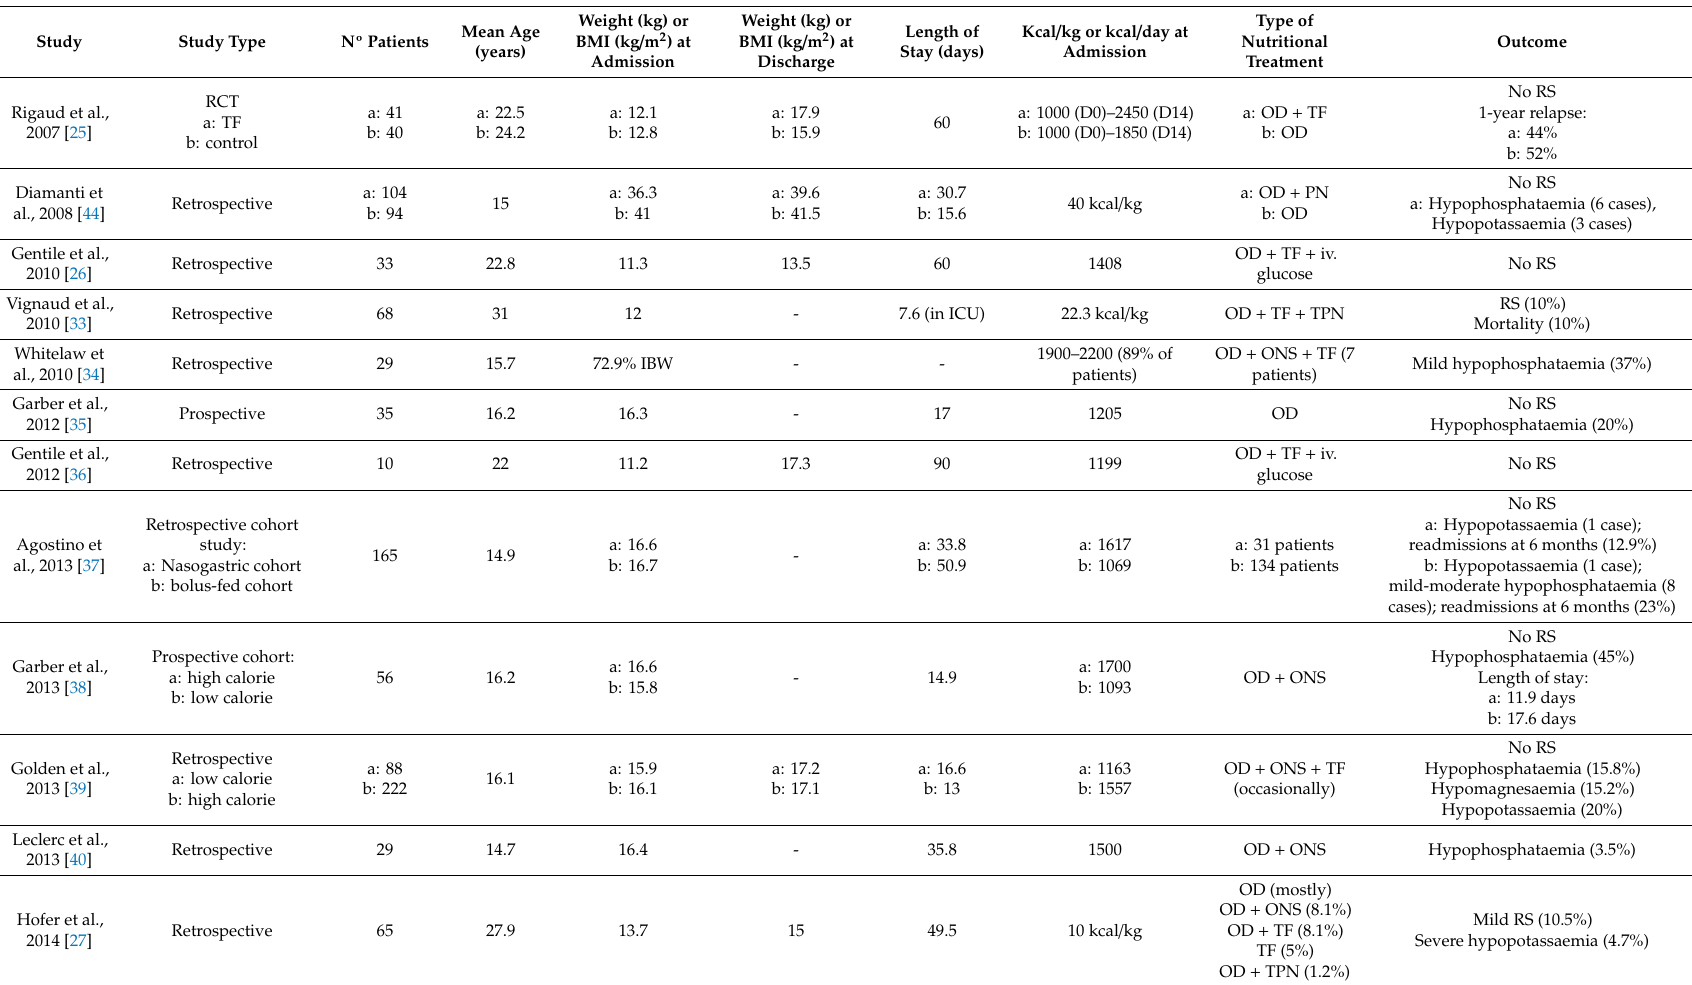
Table 6. Studies in patients with anorexia nervosa reporting clinical outcomes of the nutritional